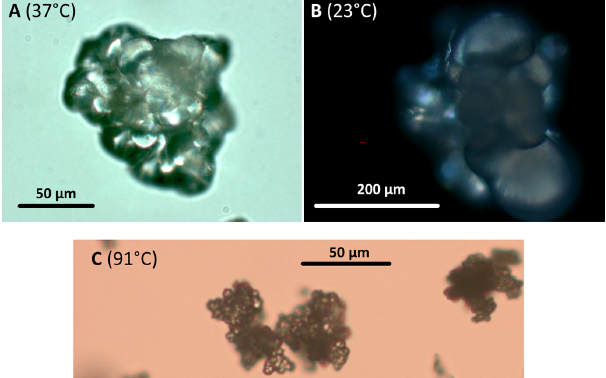
Figure 4. Close-up photomicrographs of vaterite minerals. Scale bar is 50µm in (a) and (c) , and 200µm in (b) . Panel (b) shows a vaterite crystal using polarized light.